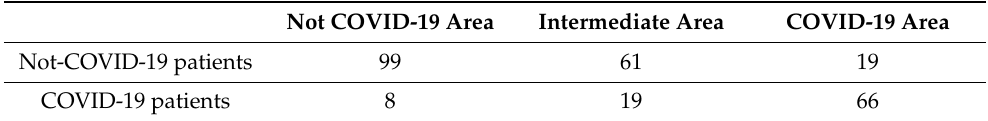
Table 7. Confusion matrix based on the logistic regression (classification in three groups). By row the actual patient status, by column their classification according to the algorithm.